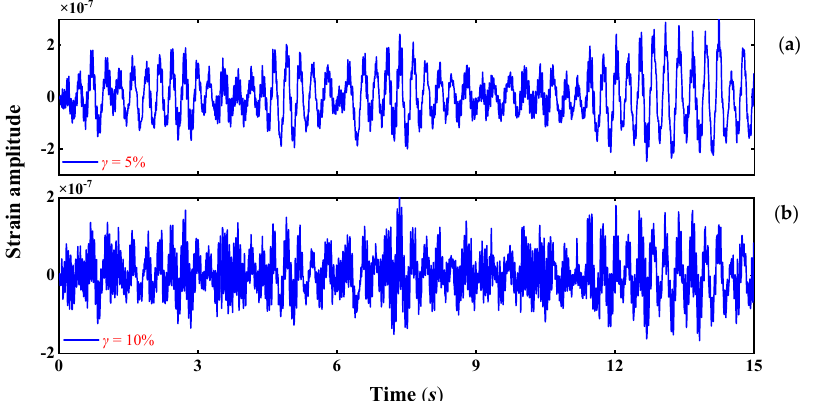
Figure 16. Strain response after adding noise at measurement point 70 under scenario I: ( a ) γ = 5%; ( b ) γ = 10%.